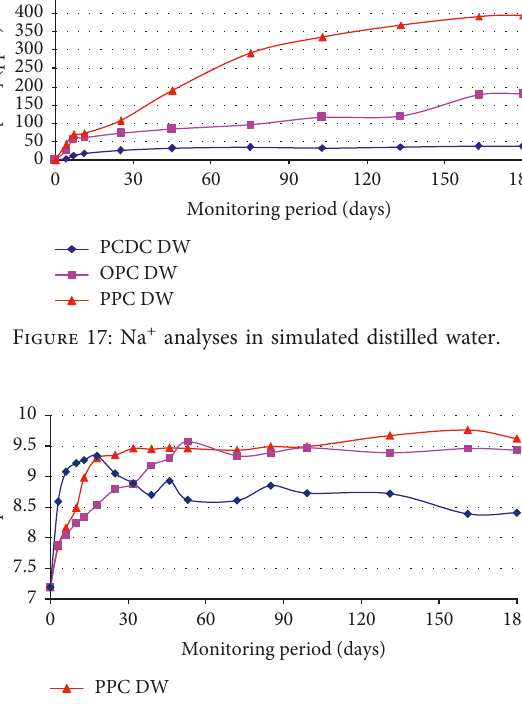
Figure 18: pH measurements in simulated distilled water.